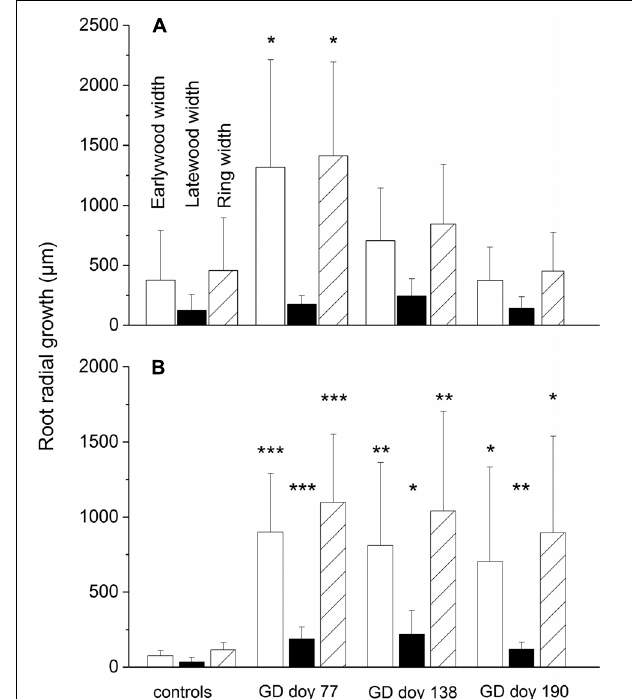
FIGURE 3 | (A–B) Radial growth of coarse roots in response to girdling in watered (A) and drought-stressed trees (B) . Bars indicate standard deviations. Asterisks indicate statistically significant differences between girdled trees and controls ( ∗ P ≤ 0.05; ∗∗ P ≤ 0.01; ∗∗∗ P ≤ 0.001; Student’s independent sample t -test). Note that the axes have different scales.